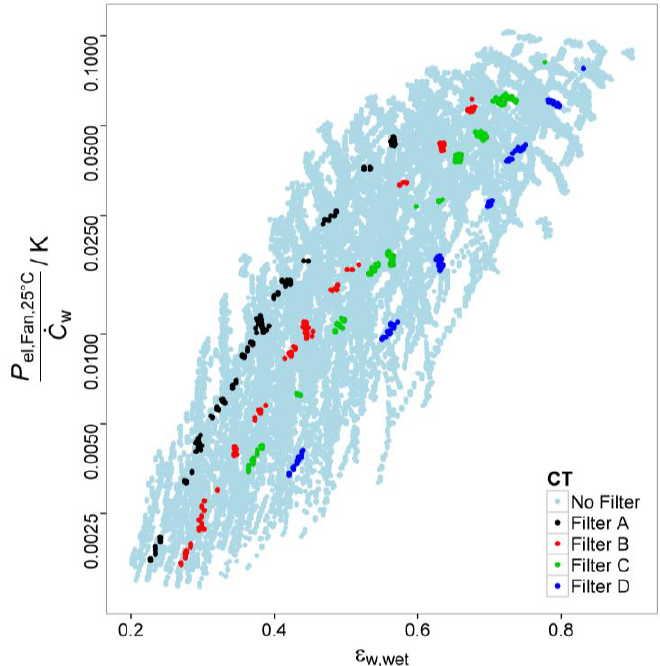
Figure 11. Electric power for fans at 25 °C ( 𝑃 ) normalized with water capacity el,Fan,25°C flow rate ( 𝐶̇ ) versus cooling effectiveness for cooling towers ( ϵ ) for simulated wet 𝑤 w,wet cooling tower Type 51 in TRNSYS 17. Unfiltered data (light blue) is based on input parameters in Table 2. Data A to D is filtered for water mass flow rate and averaged saturation specific heat. The filter is described in Table